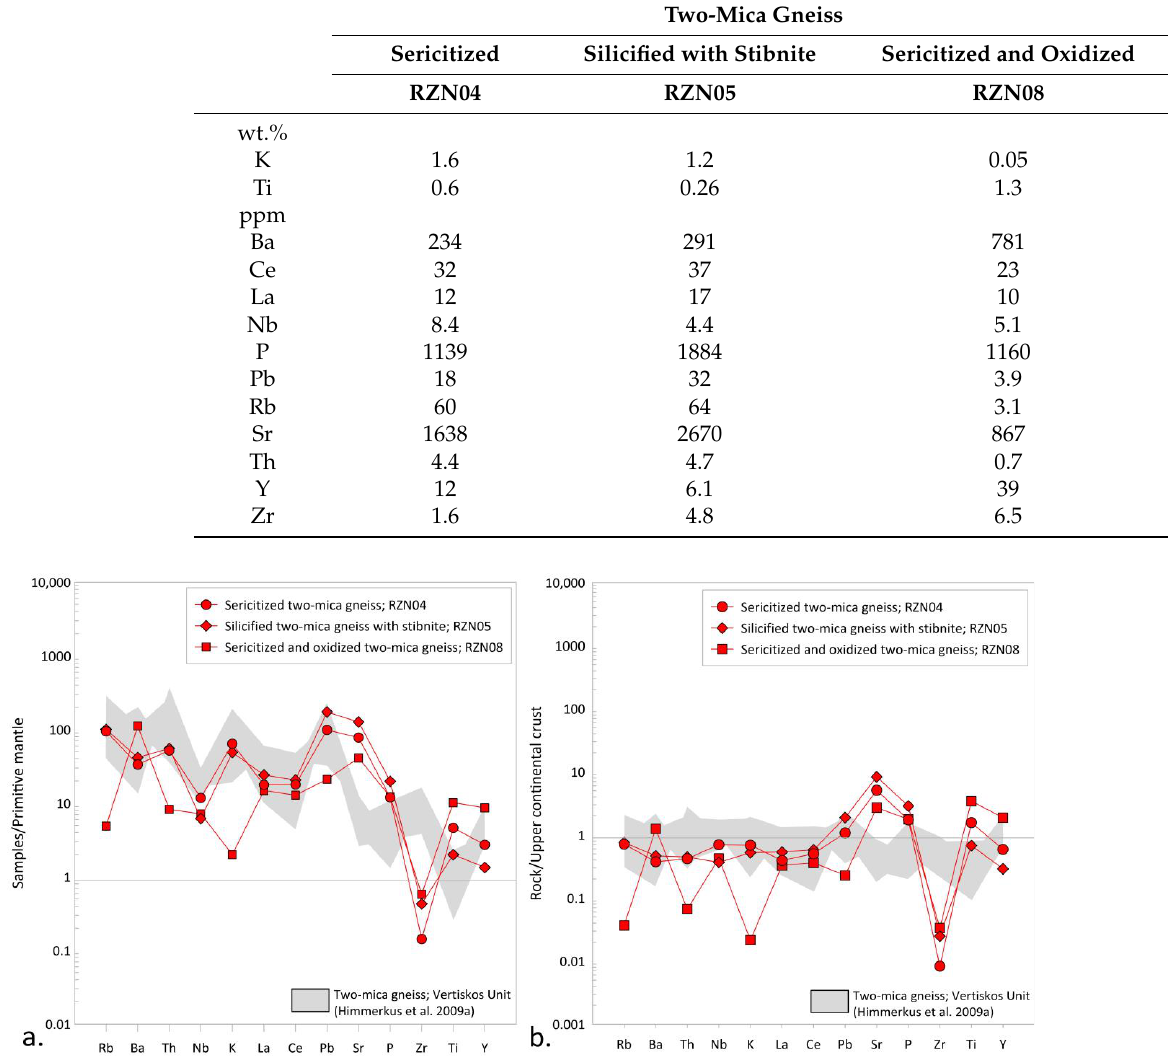
Table 3. Bulk geochemical analyses of two-mica gneiss from the Sb-mineralization at Rizana. For the full list of the geochemical analyses, see Table S1 at Supplementary Materials.